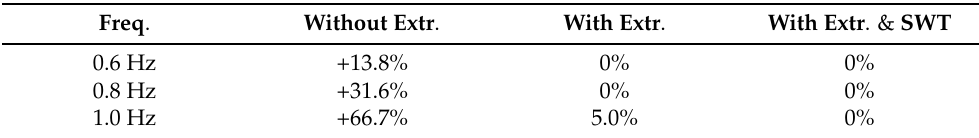
Table 1. Comparison of error of heart-rate estimated from the received original electric field at Sensor C and the extracted transmitted electric field at Sensor C. Freq . Without Extr . With Extr . With Extr . & SWT